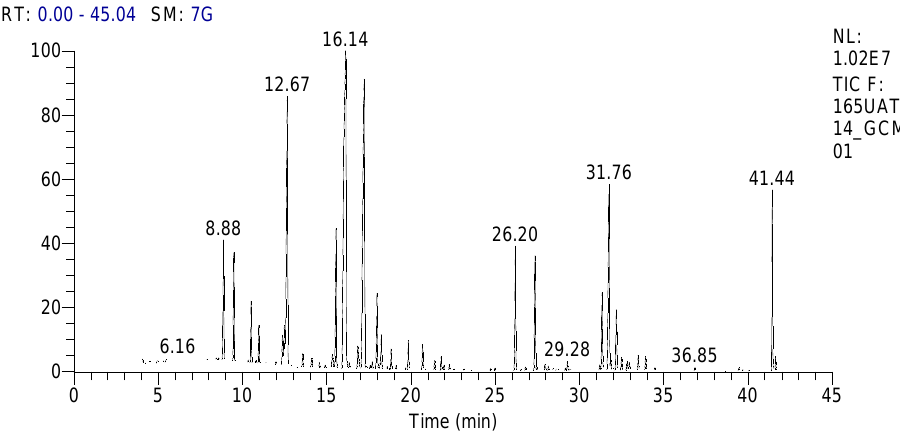
Figure 1. GC chromatography of SOEO at vegetative stage.